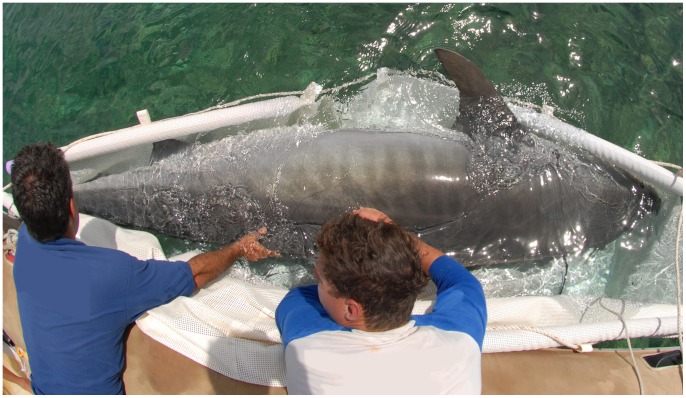
Restraint of 3.8 m tiger shark in harness.